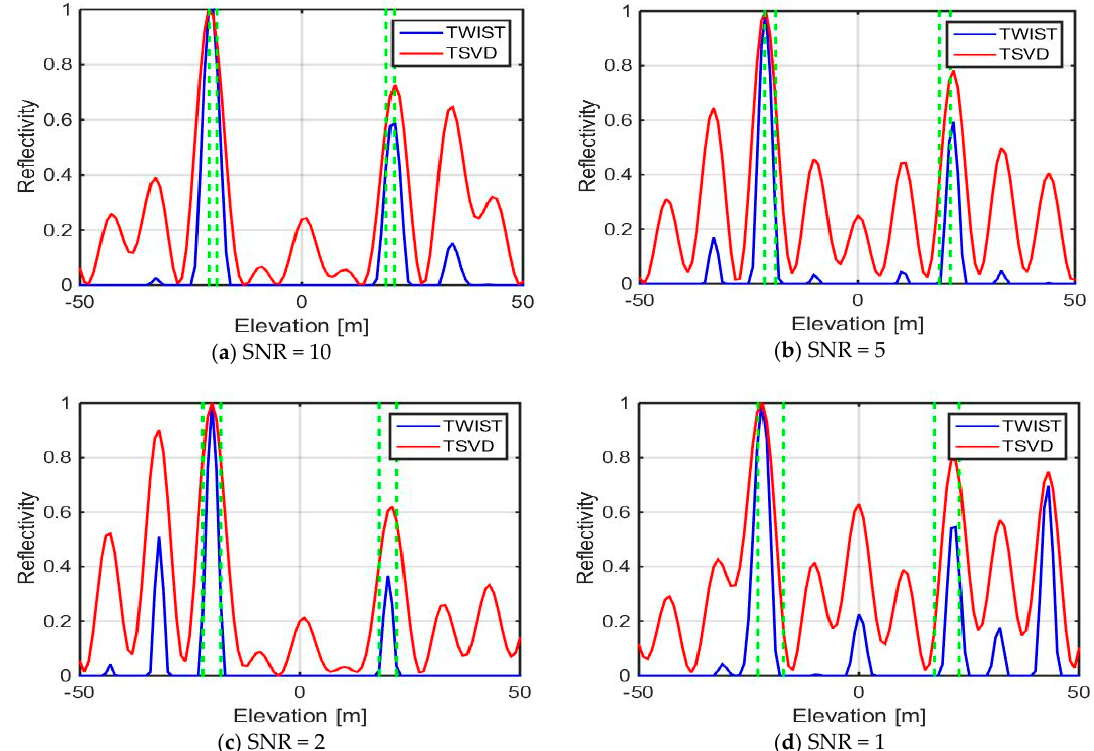
Figure 5. Tomographic performance of TWIST and TSVD on double scatters at di ff erent SNR levels when 10 MRA orbits are used.